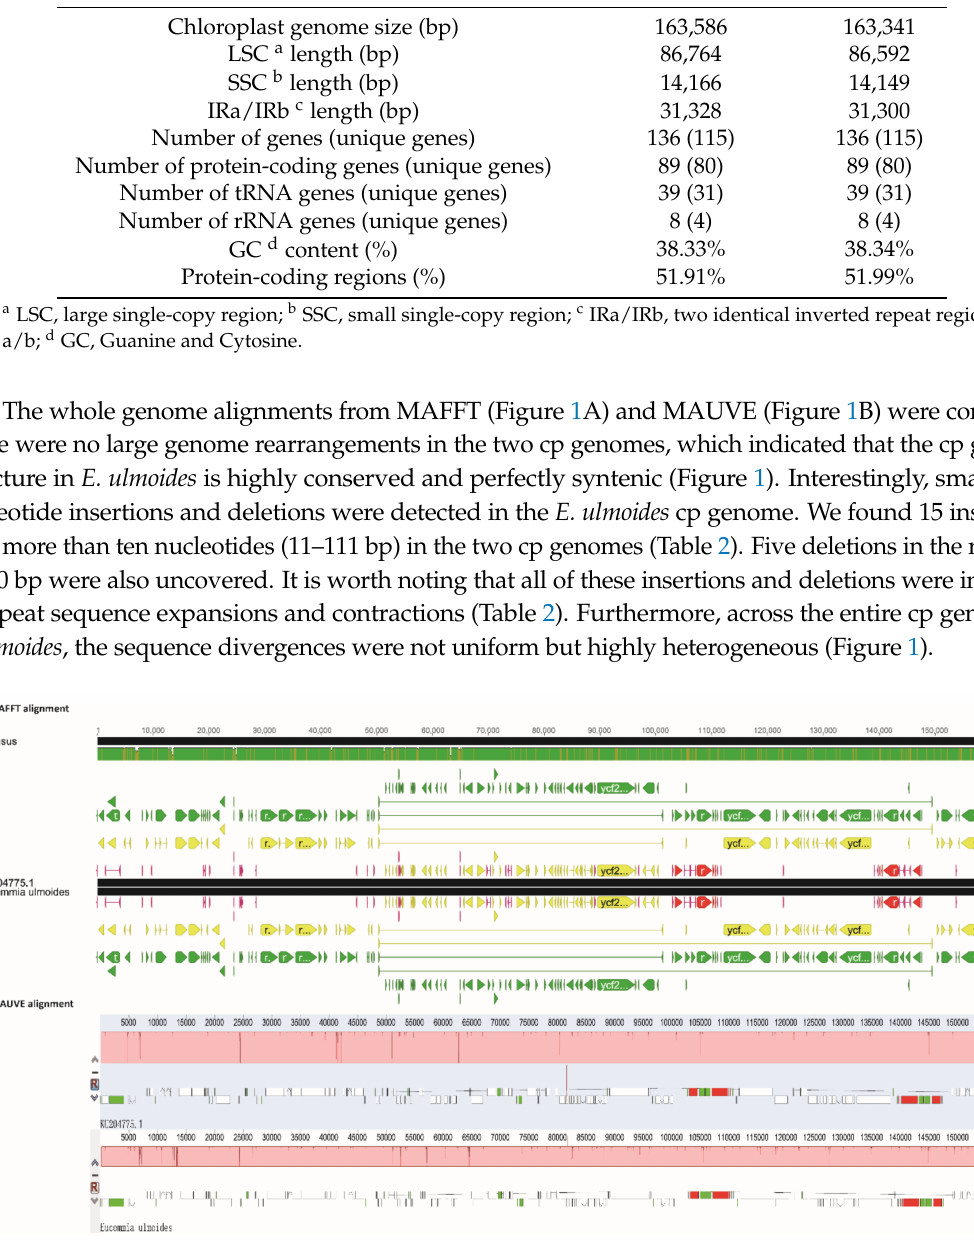
Figure 1. Conserved chloroplast genome structure in Eucommia ulmoides . ( A ) Pairwise chloroplast genome alignments derived from Multiple Alignment using Fast Fourier Transform (MAFFT) program. The sequence identity is indicated on the top. Label KU204775.1 represents the E. ulmoides chloroplast genome retrieved from GenBank, while label E. ulmoides indicates the newly sequenced genome in this study. ( B ) Pairwise chloroplast genome alignments derived from MAUVE